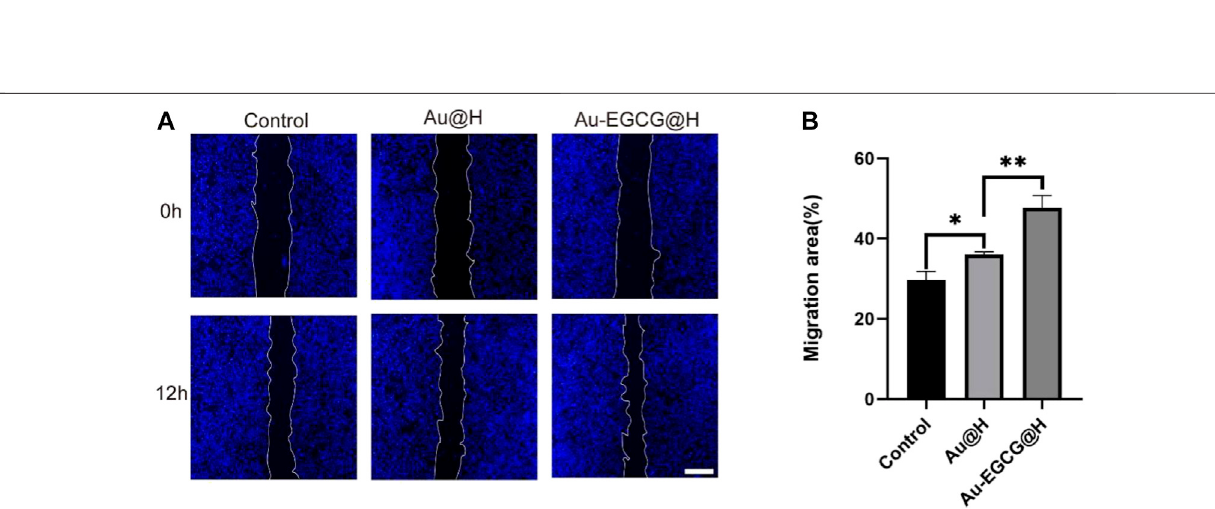
Frontiers in Pharmacology |